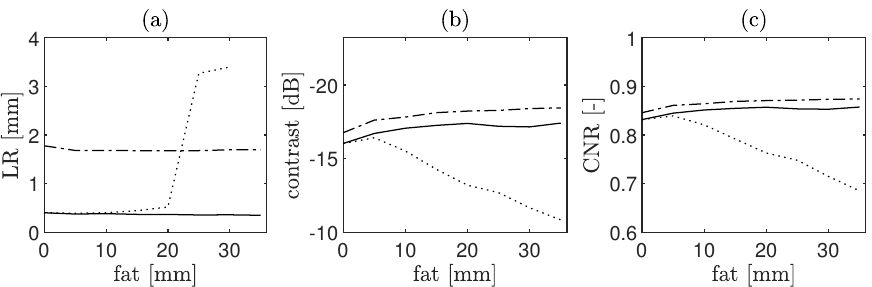
Figure 12. Computed quality metrics: ( a ) lateral resolution (LR), ( b ) contrast and ( c ) contrast-to-noise-ratio (CNR), as a function of the clutter thickness (fat layer). Three different methods are compared: one probe (solid line), 2 probes (dot line) and CoMTUS (dashed